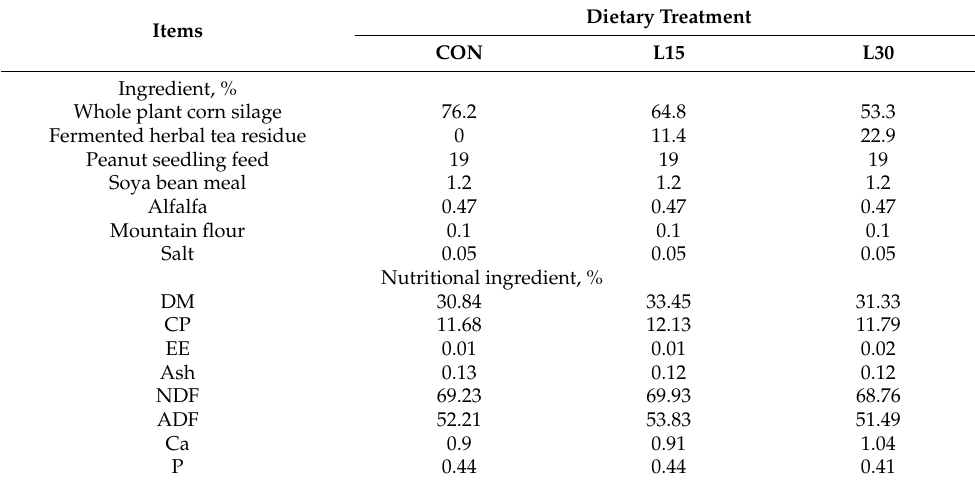
Table 1. Composition and nutrient levels of experimental diets for Chuanzhong black goats (dry matter